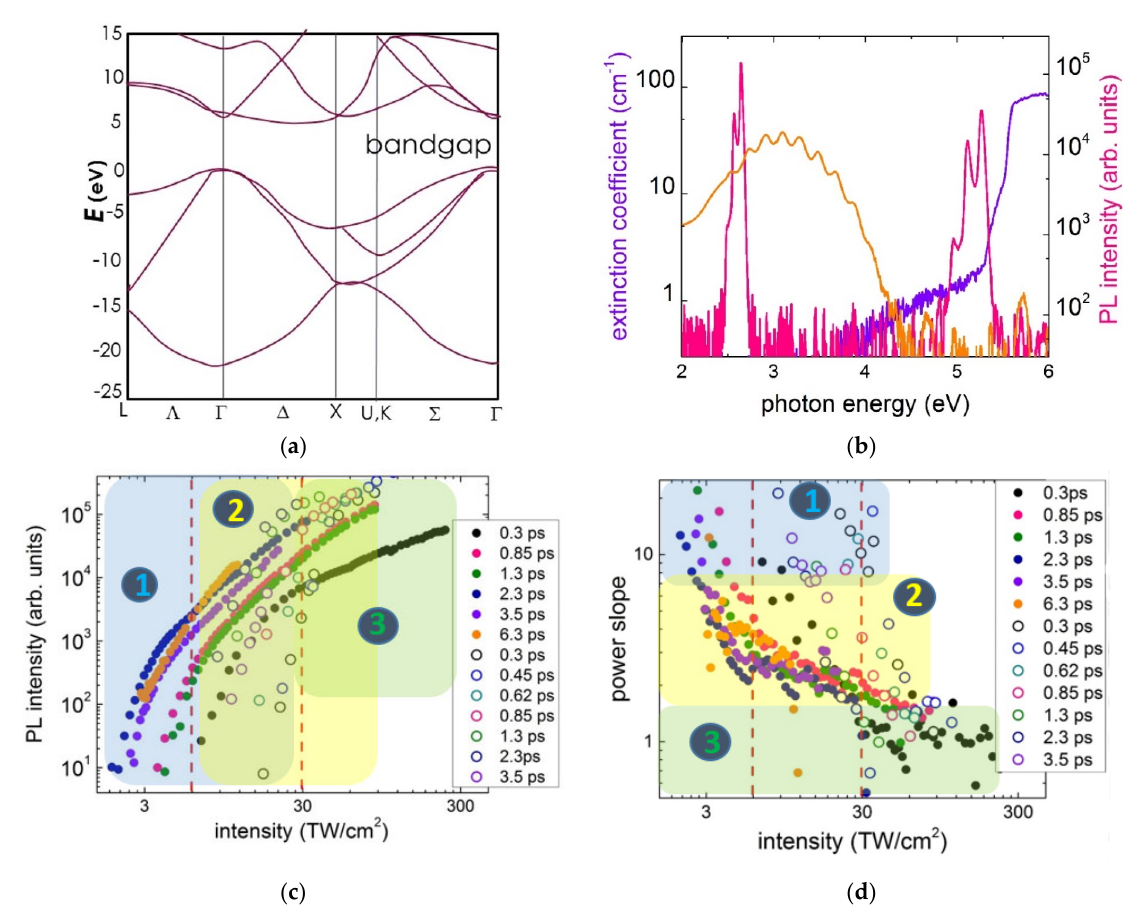
Figure 5. ( a ) Band spectrum of diamond. ( b ) Typical PL spectra of A-band and FE-recombination bands in the natural (#1) and HPHT diamonds, respectively (spectral assignment after [60,64,65]); ( c ) PL yield dependences for the diamonds at 1030 nm laser intensity at different pulsewidths and ( d ) their corresponding non-linearity slopes N φ . Dark and light dots represent HPHT and natural diamonds, respectively. The highlighted regions and numbered circles denote the corresponding EHP dynamics regimes #1–#3. Adapted from